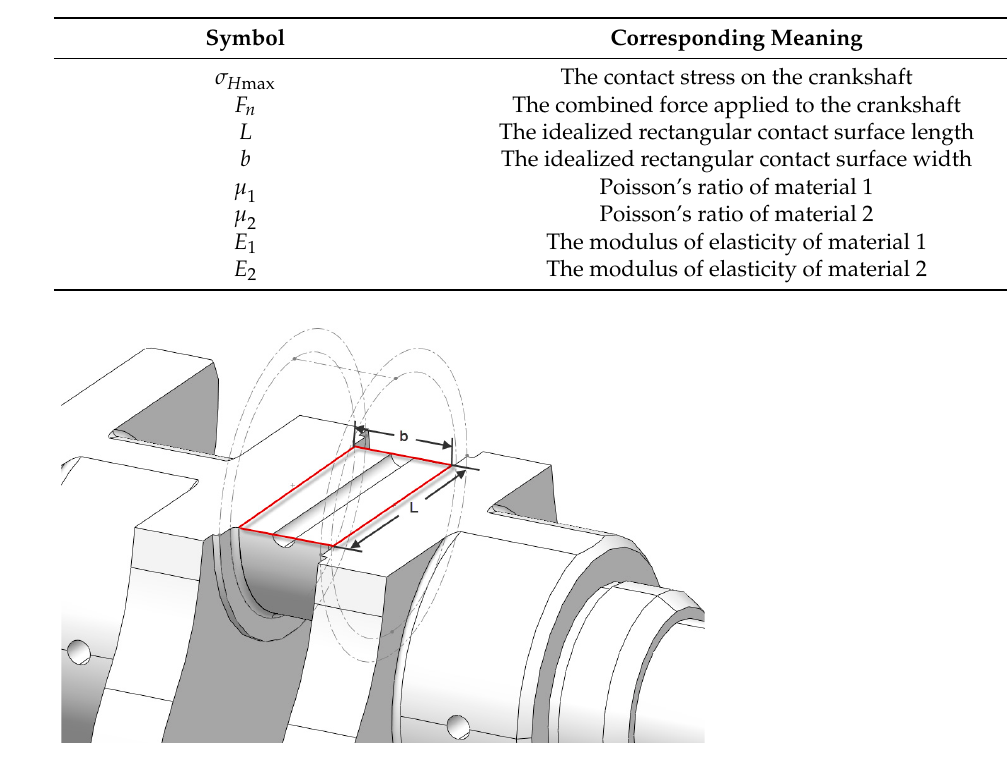
Table 1. Symbolic charts used in Equation (1).